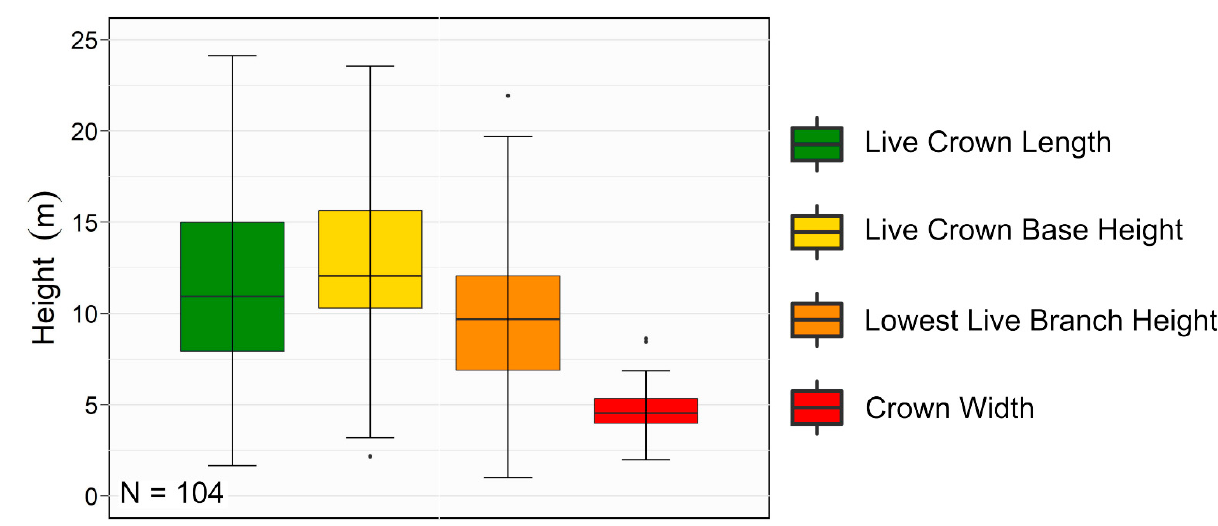
Figure 9. Box and whisker plot displaying extracted data for four crown measurements. Boxes represent the interquartile range and median values; whiskers represent the smallest and largest values within one and a half times the first and third quartiles; and points represent outliers.